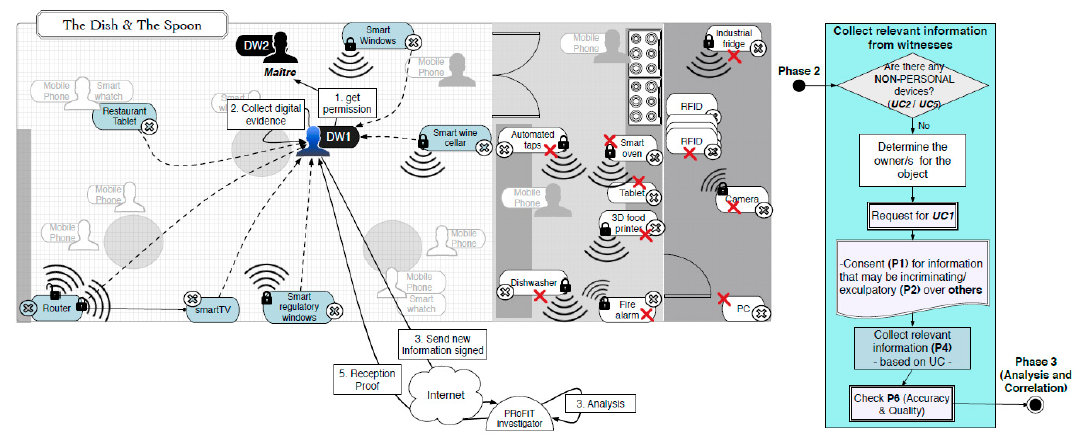
1 Figure 8. Collect relevant information from witnesses (third